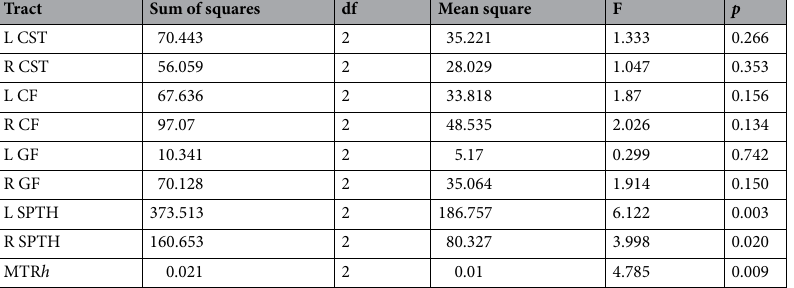
Table 2. ANOVA results between clinical group white matter tract magnetization transfer ratio (MTR) and MTR homogeneity (MTR h ) means using clinical outcome as a factor. White matter tracts are the left and right corticospinal tracts (L and R CST), cuneate fasciculus (L and R CF), gracile fasciculus (L and R GF), and the combined spinothalamic and spinoreticular tracts (L and R SPTH).